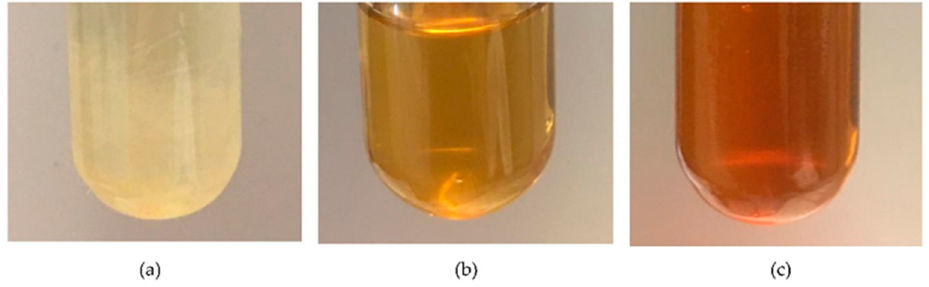
Figure 3. Influence of the reaction temperature and time on the color during maleinization of BNO, ( a ) 180 ◦ C–0 min, ( b ) 200 ◦ C–120 min and ( c ) 220 ◦ C–180